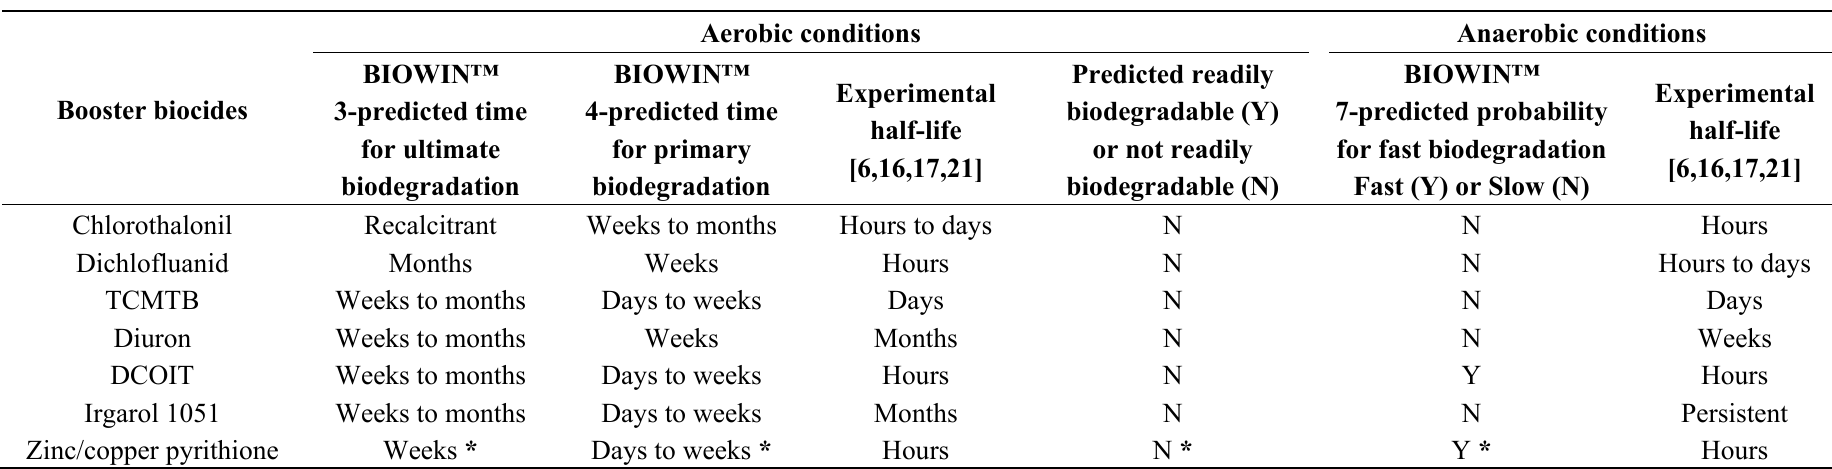
Table 2. Comparison of predicted biodegradation using BIOWIN™ 3, 4 and 7 with experimental observations. For predicted biodegradation from BIOWIN™ 3 and 4, timescale for degradation was obtained from BIOWIN™ and broadly corresponds to values of >5 = hours, >4 = days, >2 = months, <2 = recalcitrant. * Prediction for the ligand only. For predicted probability of fast biodegradation from BIOWIN™ 7, values <0.5 are considered to be not readily biodegradable (N). For experimental data, we define < 24 h = hours, 24 h < days < 168 h/7 days, 168 h/7 days < weeks < 30 days, months > 30